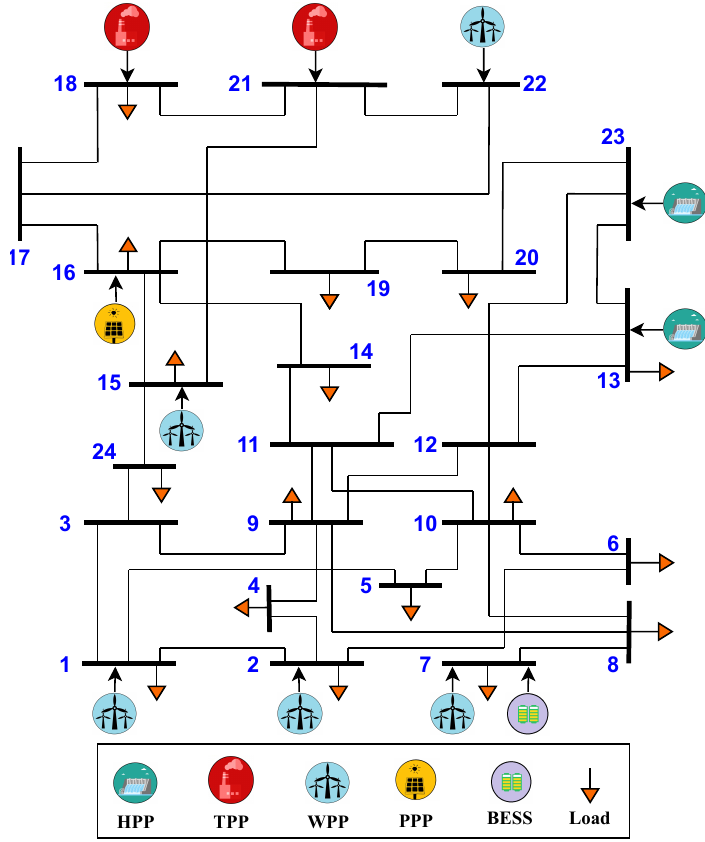
Figure 4. Diagram of modified IEEE 24-bus power system.